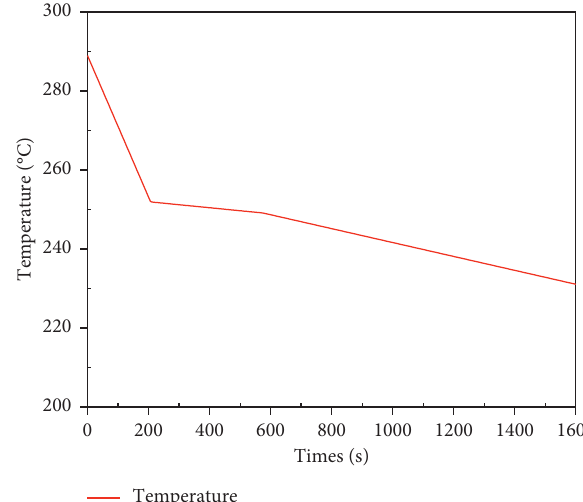
Figure 15: Temperature distribution at the maximal stress location in the RPV model during the AOO transient.